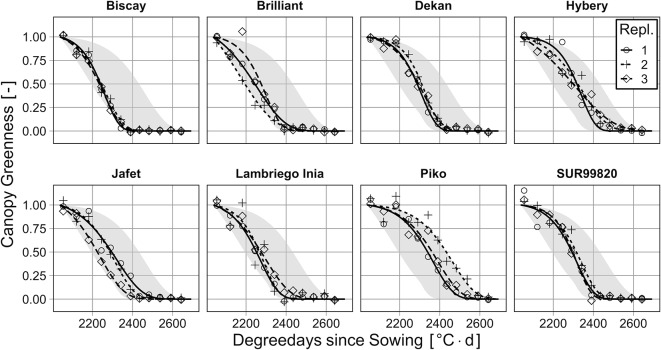
Canopy greenness for eight genotypes, grouped by replication (Repl.), in relation to degree days since sowing. The grey ribbon indicates the range of all genotypes to facilitate their classification.